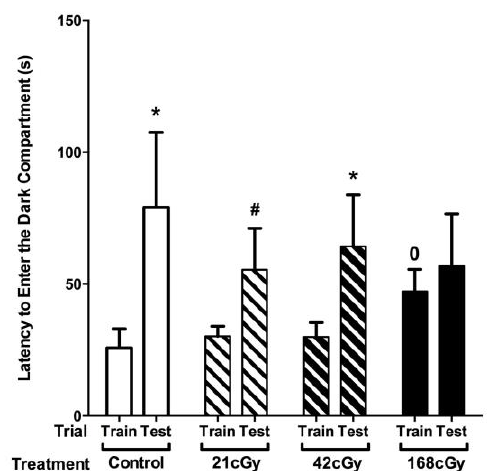
Figure 3. Passive avoidance learning and memory. There were effects of irradiation when the time to enter the dark compartments on Days 1 and 2 were compared using a repeated-measures design within each dose condition. In sham-irradiated mice and mice irradiated with 42 cGy, the latency to enter the dark compartment was significantly higher on Day 2 than Day 1. This did not reach significance in mice irradiated with 21 cGy, and the latency to enter the dark compartment in mice irradiated with 168 cGy was comparable on both days ( p = 0.27). Control: n = 13 mice; 21 cGy: n = 23 mice; 42 cGy: n = 20 mice; 168 cGy: n = 16 mice. * p < 0.05; # p = 0.078; 0 p = 0.0693.